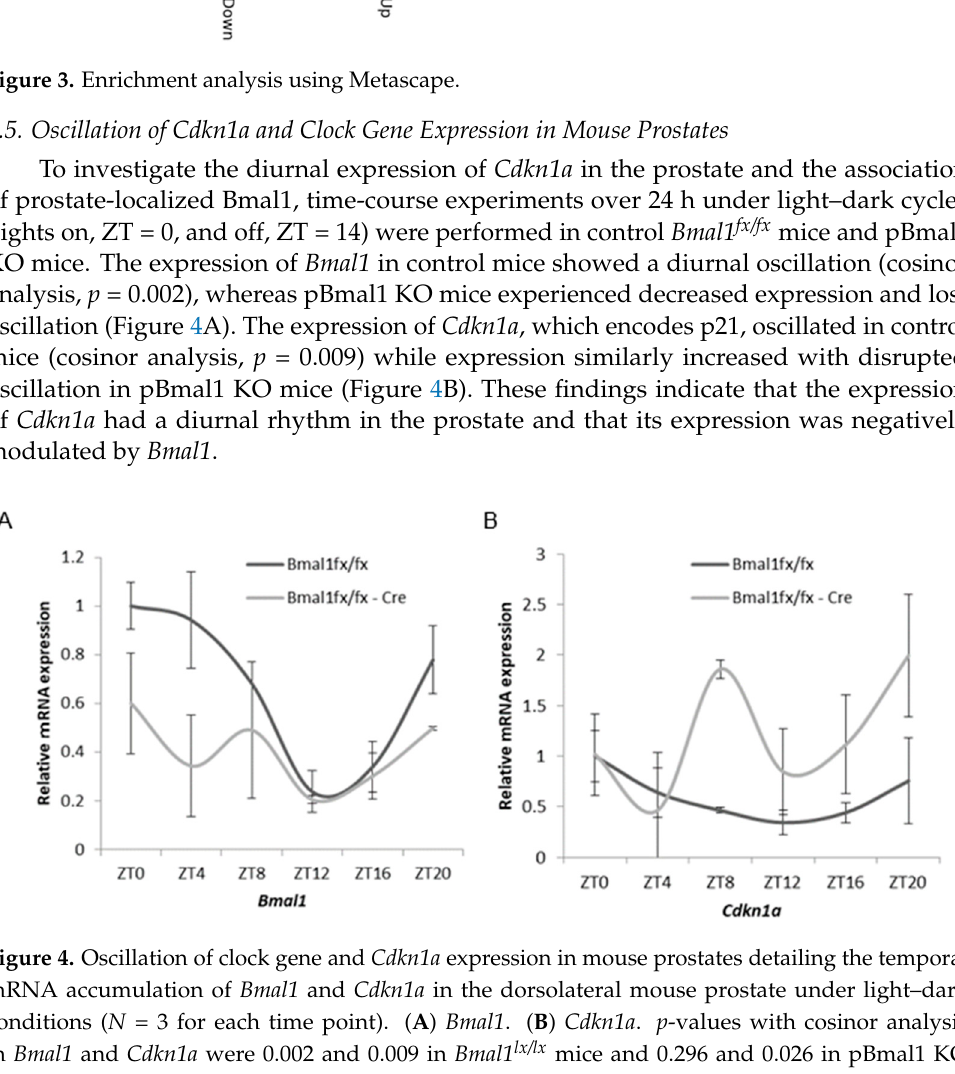
Figure 5. Representative images of protein expression levels of p21 in the prostate. ( A ) Immunob- lotting of dorsolateral prostates at ZT16. ( B ) Immunohistochemistry of ventral prostates. Stromal cells showed positive staining in pBmal1 KO mice (shown by arrows) but little in Bmal1 fx/fx mice. 2.7. Proliferation Assay (WST-8 Assay) in BMAL1-Knockdown Immortalized Human Prostate Cells To further investigate the role of BMAL1 in the growth of the prostate, a WST-8 assay was performed using immortalized human prostate cells. Here, BMAL1 knockdown (Fig- ure S3) reduced cell growth in both epithelial and stromal cells (Figure 6A,B), indicating that BMAL1 was required for optimal proliferation at the cellular level even in trans- formed cells.